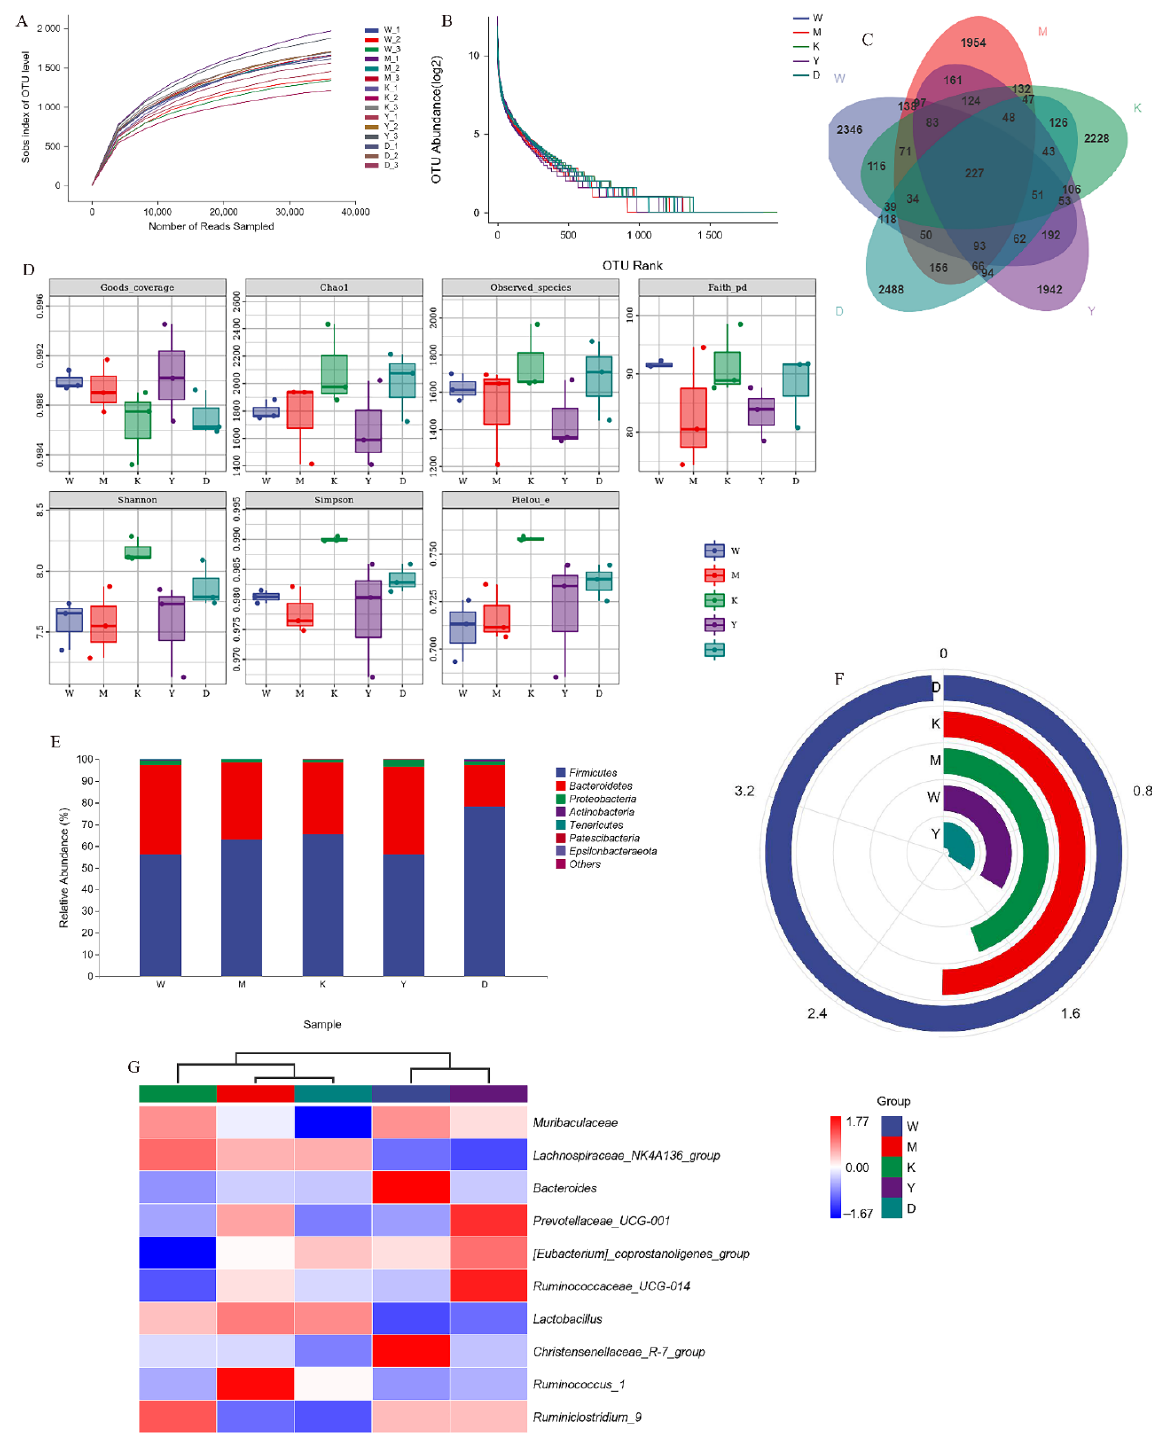
Figure 7. The influence of composition and diversity of gut microorganisms of rats in each group after pea peptide and double peptides intervention. ( A ) Rarefaction curve; ( B ) Rank abundance curve; ( C ) Venn diagram of AVS number; ( D ) α -diversity index; ( E ) The proportion of the top 7 species composition at the phylum level; ( F ) The ratio of F/B in the gut; ( G ) Heatmap showing the normalized Z-score values of microorganism abundances at the genus level. W: WKY, M: SHR, K: SHR-C, Y: SHR-DP, D: